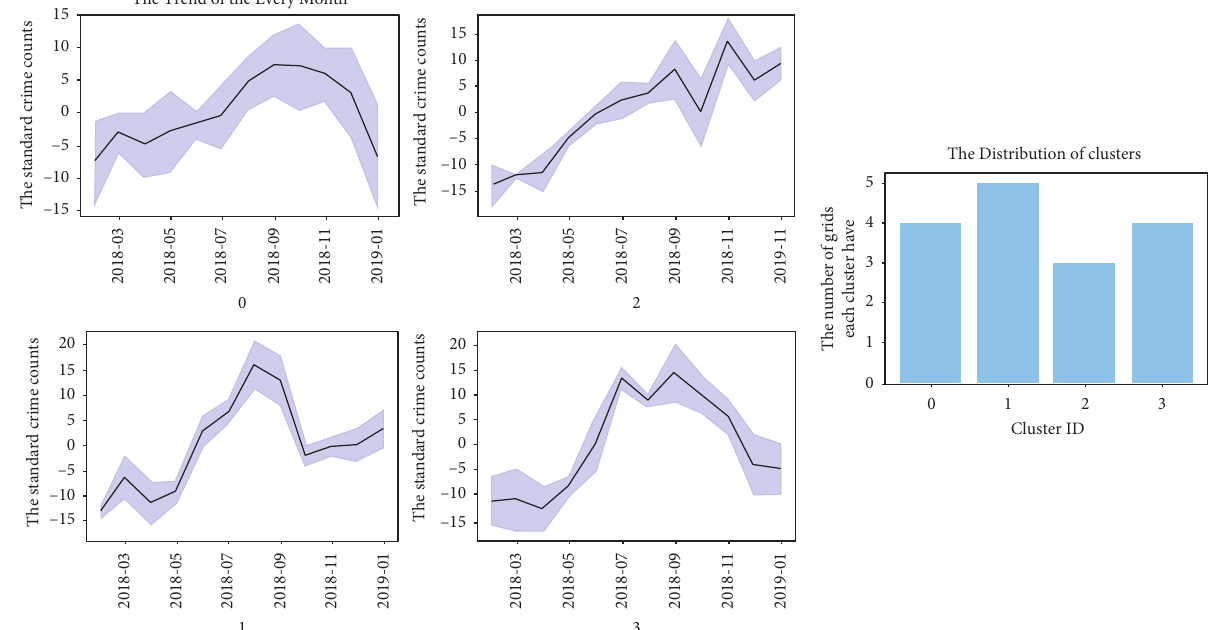
Figure 21: The theft in New York trends in each month in 2018 and the distribution of clusters. The line charts are the monthly trends of theft in New York in 2018. The bar chart is the distribution of the clusters.